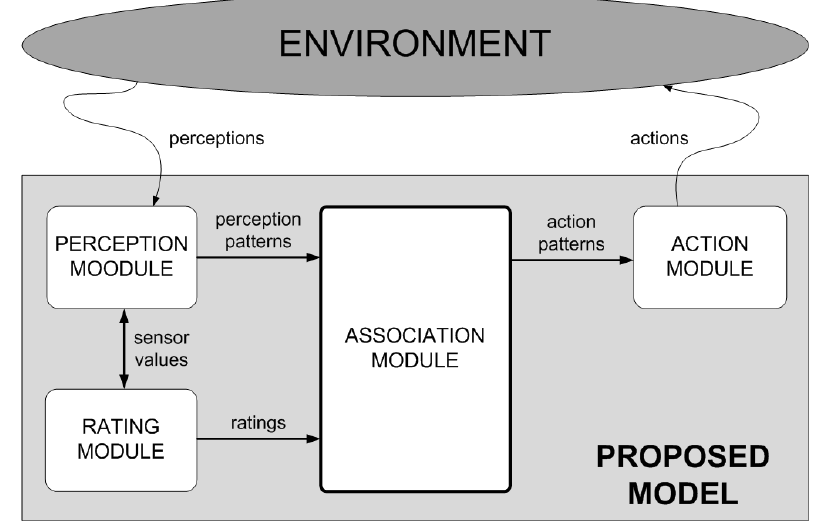
Figure 2. Overview of the proposed model.